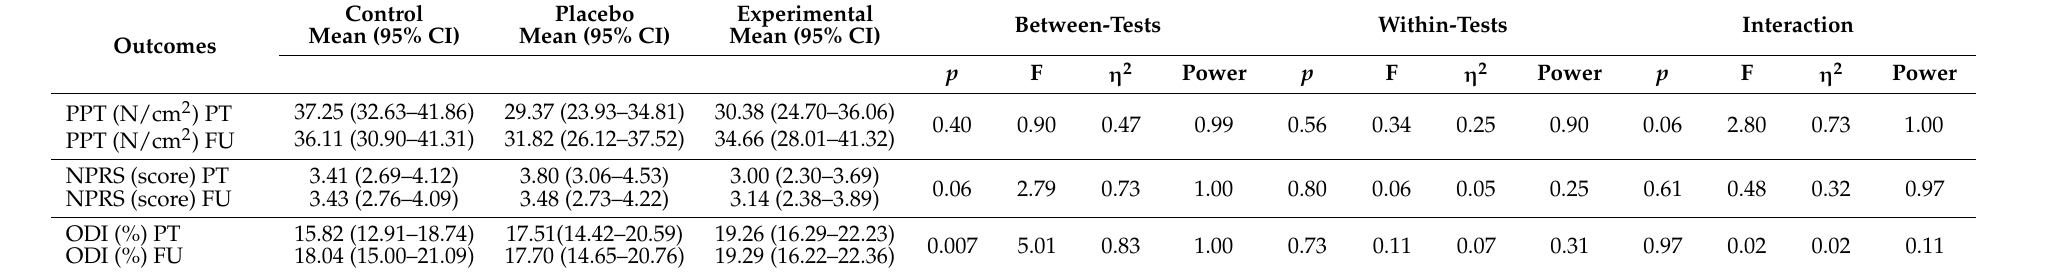
Table 2. Statistical results between-tests, within-tests and interaction for